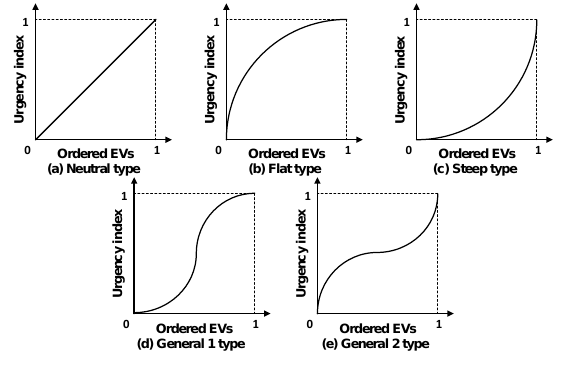
Fig. 2 Five typical